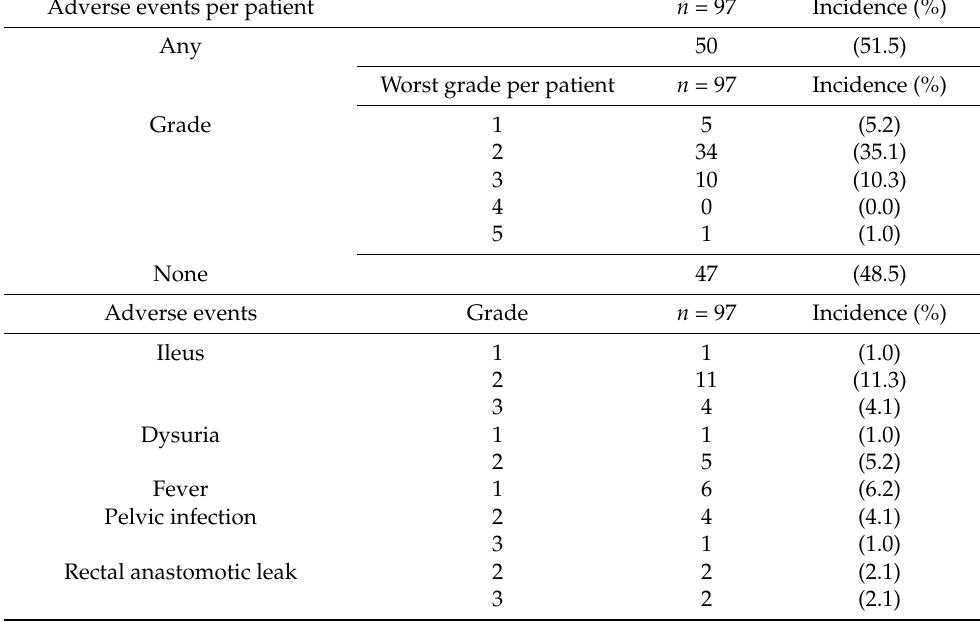
Table 4. Perioperative